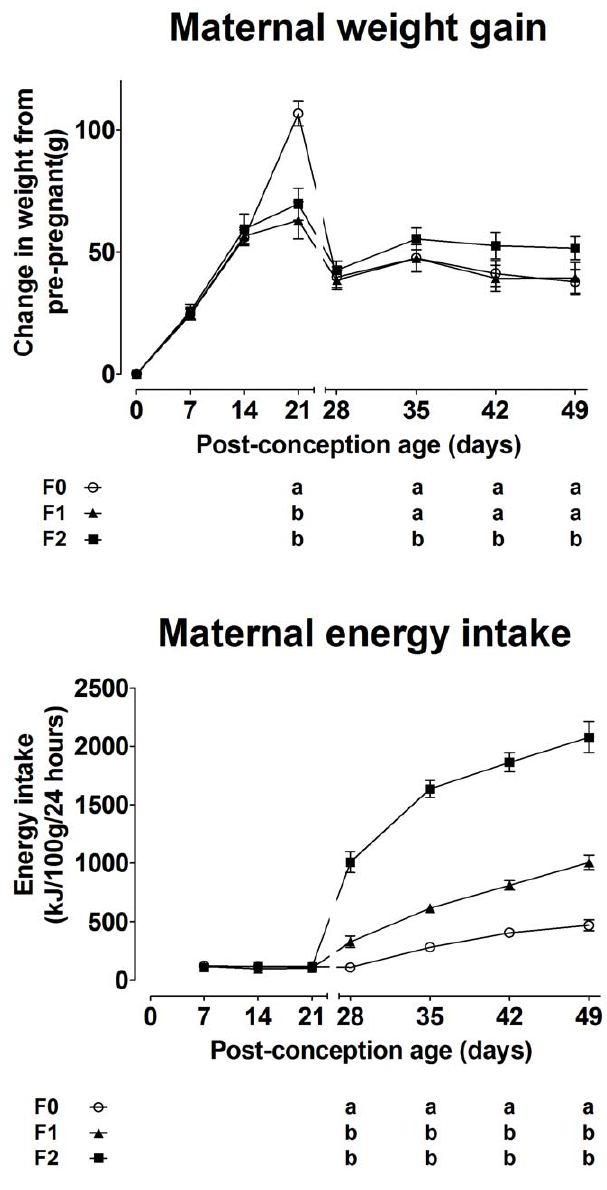
Figure 2. Change in maternal body weight from conception and energy intake during pregnancy and lactation. Values are mean 6 SD for n=5 2 7 rats per group. Different letters indicate significantly different (P , 0.05) values between generations.